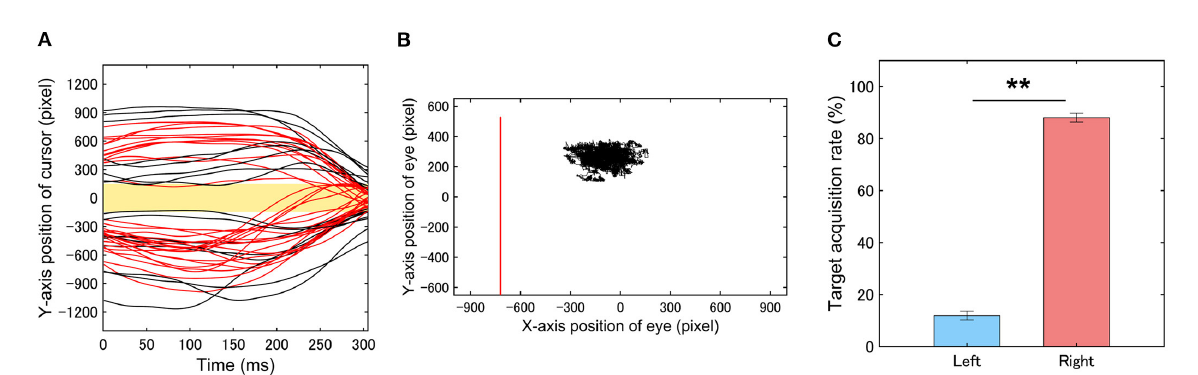
FIGURE7 (A) Typical examples of trial trajectories of the cursor movement along the Y-axis. Red and black lines indicate Hit and Miss trials, respectively. Light yellow rectangle indicates ‘’Hit zone”. (B) Typical examples of eye movements while performing the CVM task. Red lines show the cursor movement. (C) Target acquisition rate of the left- and right-side visual fields from the appearance of the target to the onset of the RCA. Participants acquired the target information in their right-side visual field predominantly to start the RCA. Error bars are SEM. ** p < 0.01.